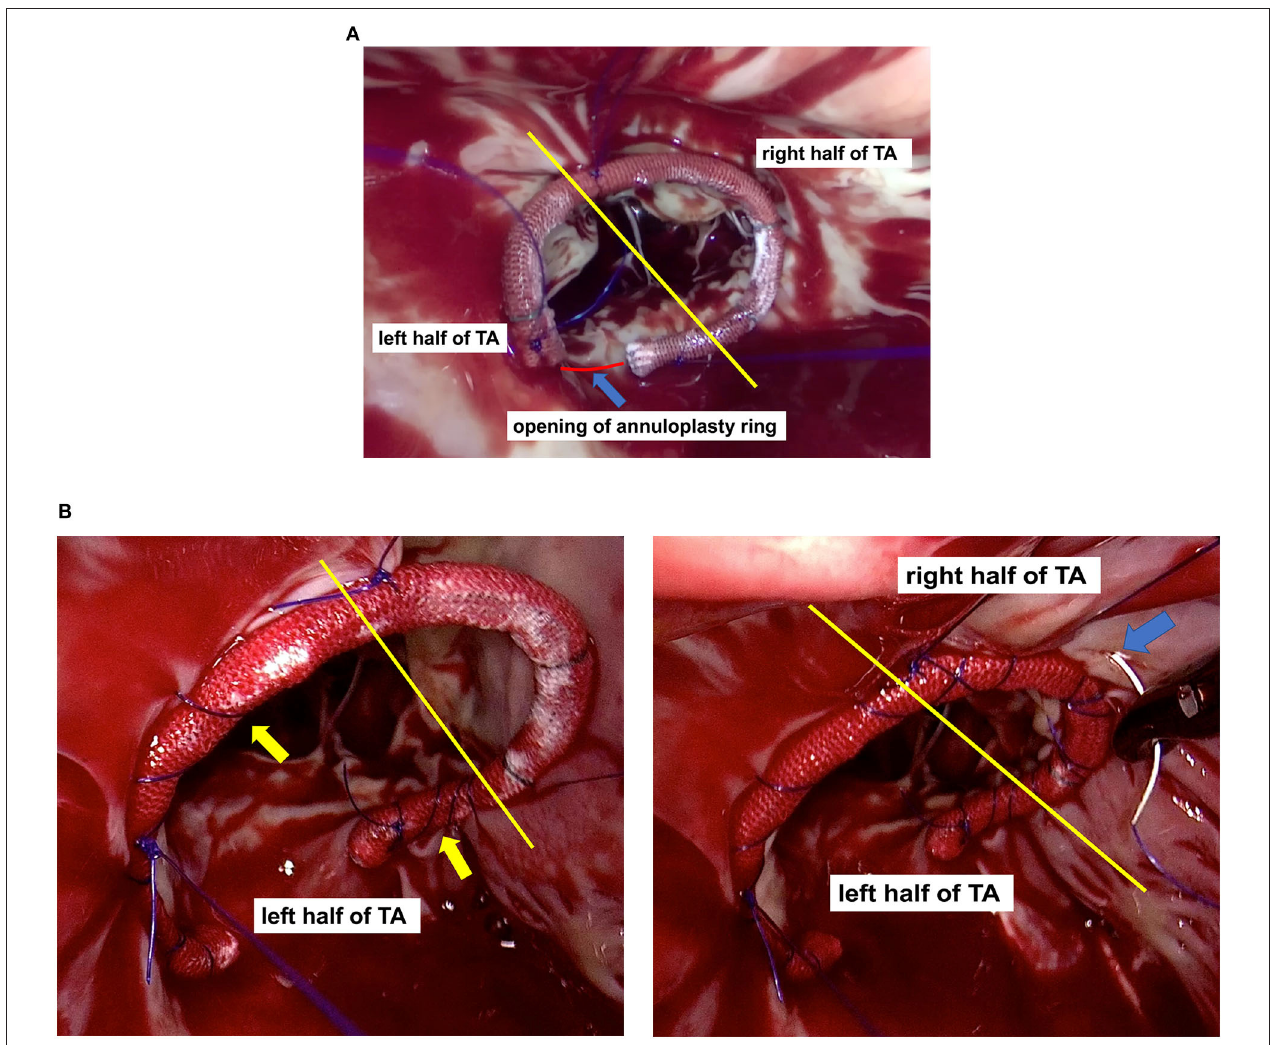
FIGURE 1 | The yellow line divides the tricuspid annulus (TA) into the left and right half parts. (A) Annuloplasty ring positioning: Regardless of the mark line on the ring, the opening of the annuloplasty ring (blue arrow) was aligned with the Koch’s triangle (red line), and the anterior leaflet segment (or its left part) of the annuloplasty ring was aligned with the anterior leaflets of the tricuspid valve; (B) Modified continuous suture: 1) Continuous suturing of the annuloplasty ring to the TA, in a bundling manner (yellow arrow); 2) The right half of the TA (blue arrow) was firmly constricted, whereas its left half was